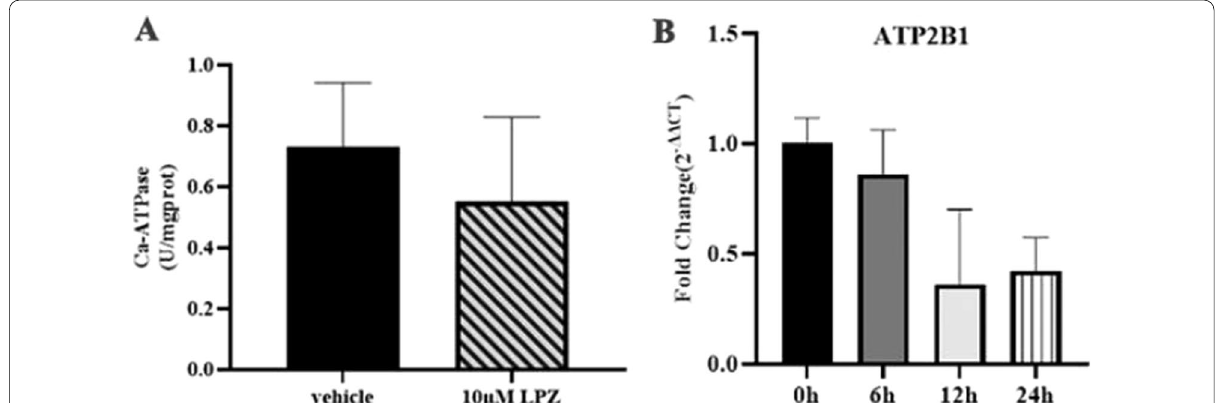
Fig. 12 Effects of LPZ on Ca 2 + -ATPase in MC3T3-E1 cells. A LPZ reduced Ca 2 + -ATPase activity. B LPZ inhibited plasma membrane Ca 2 + -ATPase gene expression (n =